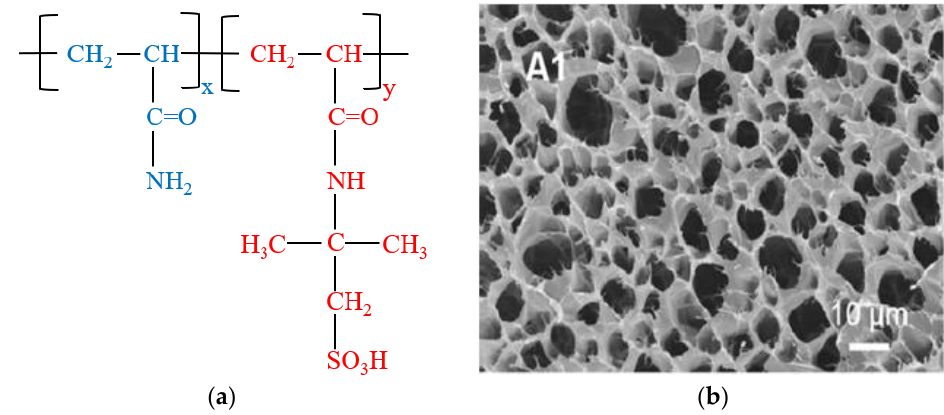
Figure 4. ( a ). Molecular structure of the AM-AMPS copolymer. ( b ). Microstructure of the AM-AMPS polymer.